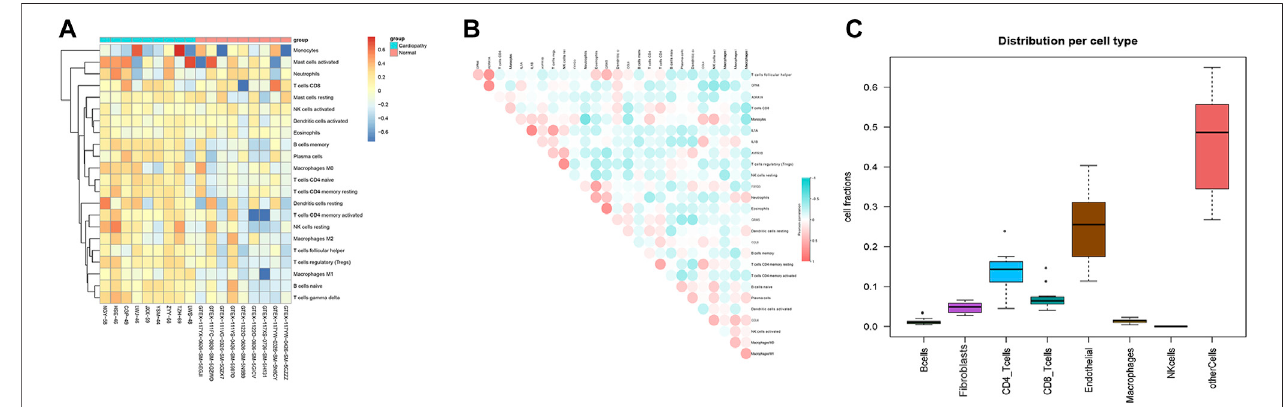
FIGURE 9 | Immune in fi ltration analysis of integrated data and correlation of hub genes with immune cells. The results of immune in fi ltration evaluation of the integrated samples ( Figure 9A ). Evaluation of the correlation between each immune cell and key hub gene ( Figure 9B ). Correlation coef fi cients of the proportion of immune cells in fi ltrating the samples in the disease group ( Figure 9C